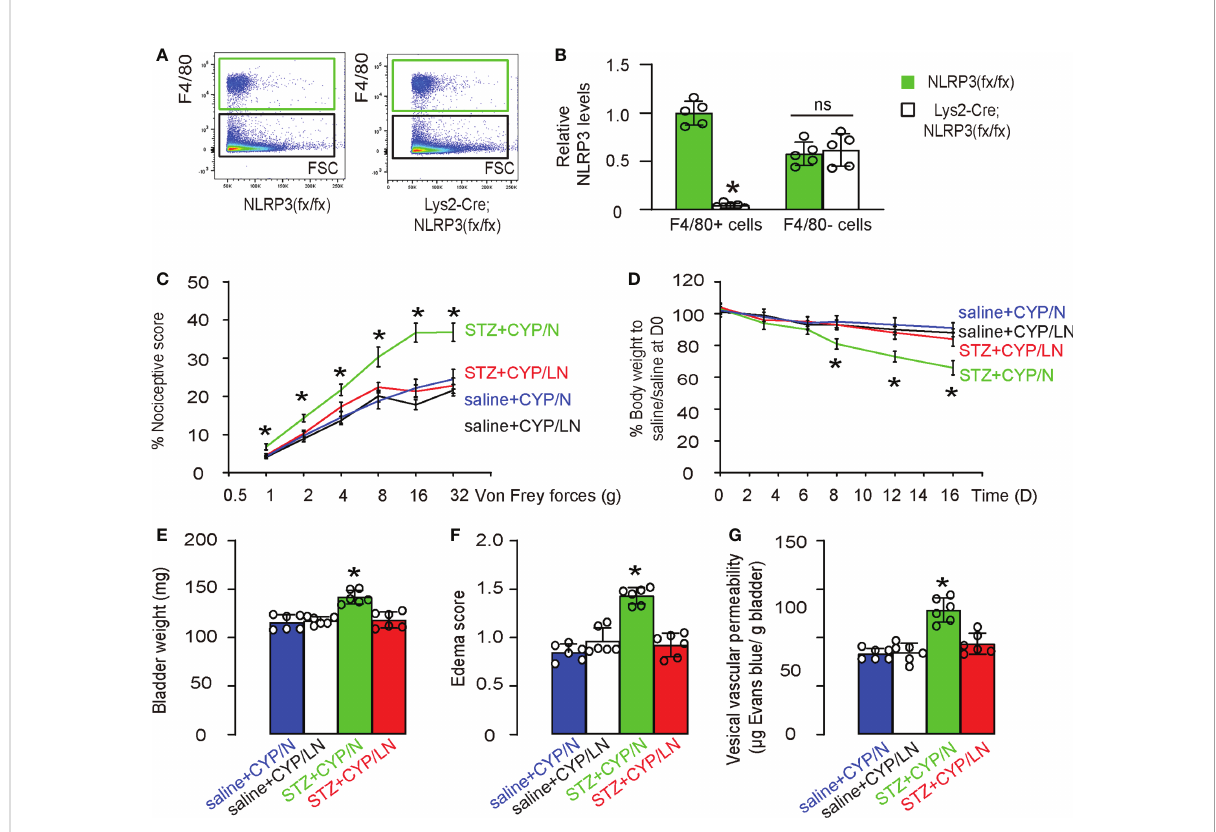
FIGURE 7 Speci fi c depletion of NLRP3 in macrophages alleviates the severity of cystitis in diabetic mice. We generated mice with macrophage-depletion of NLRP3, Lys2-Cre; NLRP3(fx/fx) and control NLRP3(fx/fx). (A) Flow cytometry showing isolation of macrophages from the bladders of these mice. (B) ELISA for NLRP3 in macrophages nor non-macrophages from the mouse bladder. (C) STZ was used at D0 to develop diabetes in mice. After 6 days when diabetes was con fi rmed, experimental cystitis was induced by 4 i.p. injection of CYP on D6, 8, 10 and 12. Von Frey test was done at D13, and mice were sacri fi ced at D16 for end assessments. Group 1: NLRP3(fx/fx) mice received i.p. saline (control for STZ) at D0 and i.p. CYP at D6, 8, 10 and 12 (saline+CYP/N); Group 2: Lys2-Cre; NLRP3(fx/fx) mice received i.p. saline (control for STZ) at D0 and i.p. CYP at D6, 8, 10 and 12 (saline+CYP/LN); Group 3: NLRP3(fx/fx) mice received i.p. STZ at D0 and i.p. CYP at D6, 8, 10 and 12 (STZ+CYP/N); Group 4: Lys2- Cre; NLRP3(fx/fx) mice received i.p. STZ at D0 and i.p. CYP at D6, 8, 10 and 12 (STZ+CYP/LN). (C) Nociceptive score of the mice at Von Frey test at D13. (D) Changes in body weight. (E) Bladder weight at D16. (F) Edema score of the bladder at D16. (G) Vesical vascular permeability in bladder at D16. *p<0.05. ns: no signi fi